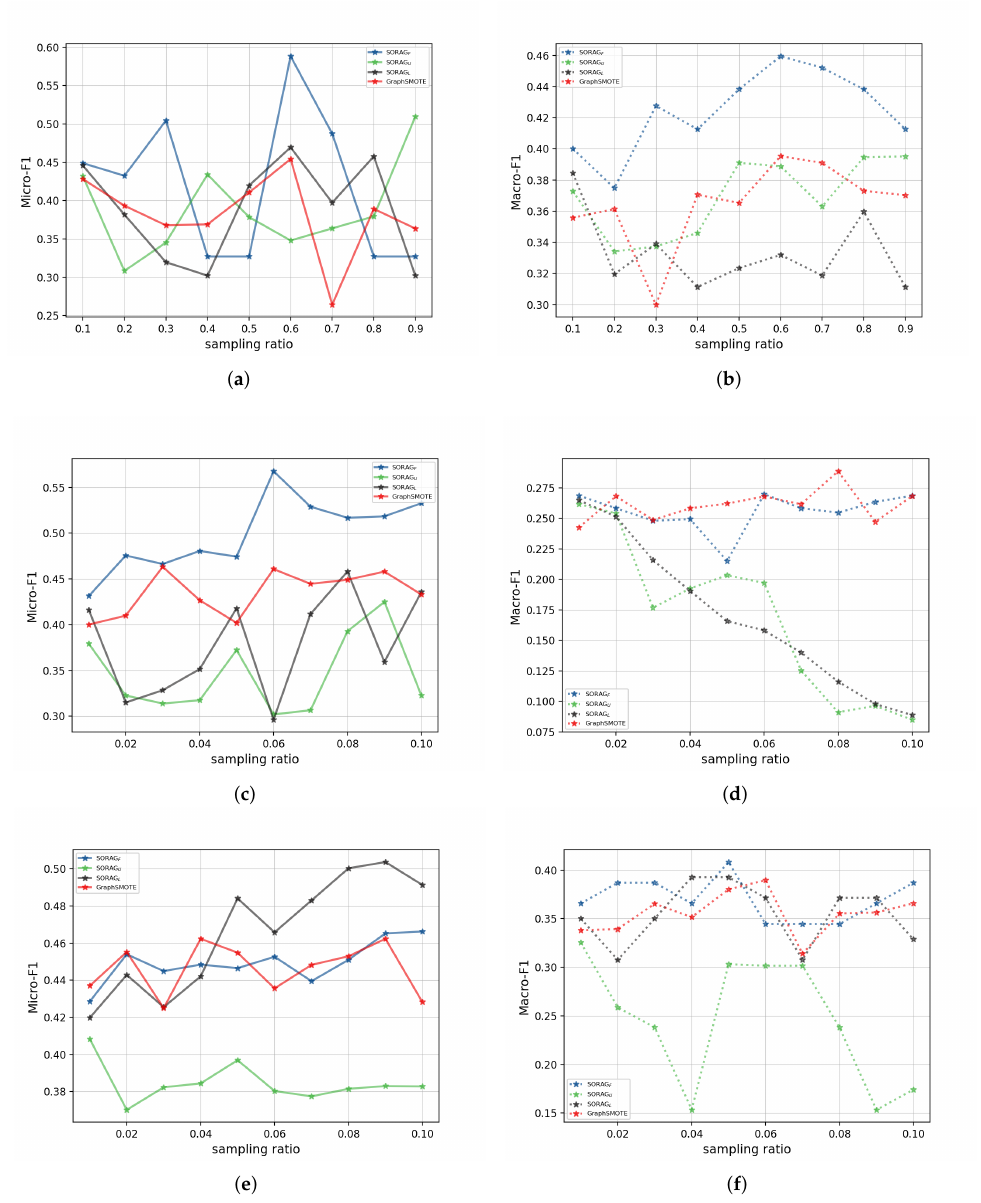
Figure 4. Performance of selected methods with reference to sampling ratio: ( a ) B LOG C ATALOG 3, M ICRO -F1; ( b ) B LOG C ATALOG 3, M ACRO -F1; ( c ) F LICKR , M ICRO -F1; ( d ) F LICKR , M ACRO -F1; ( e ) Y OU T UBE , M ICRO -F1; ( f ) Y OU T UBE , M ACRO